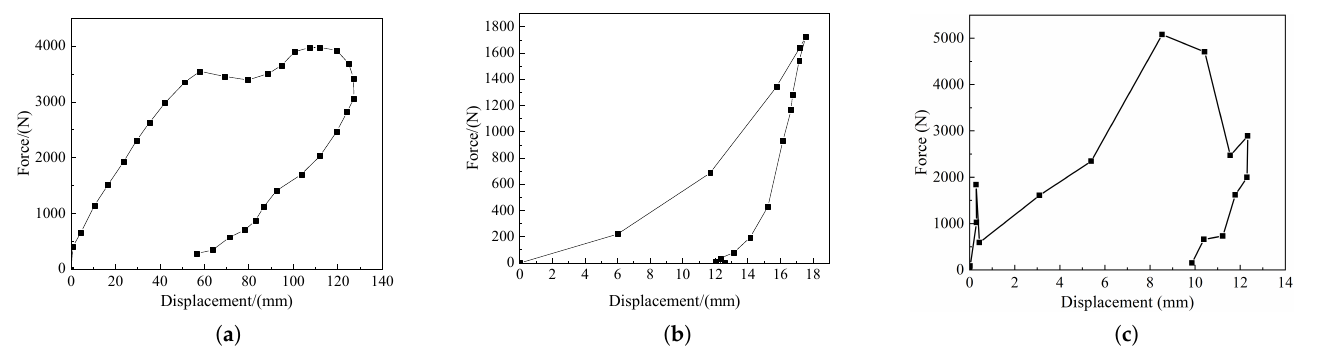
Figure 15. Force-displacement collision curves: ( a ) Force-displacement curve for cadaver testing; ( b ) pendulum simulation force–displacement curve of the pig model; ( c ) pendulum simulation force–displacement curve of the cow model.